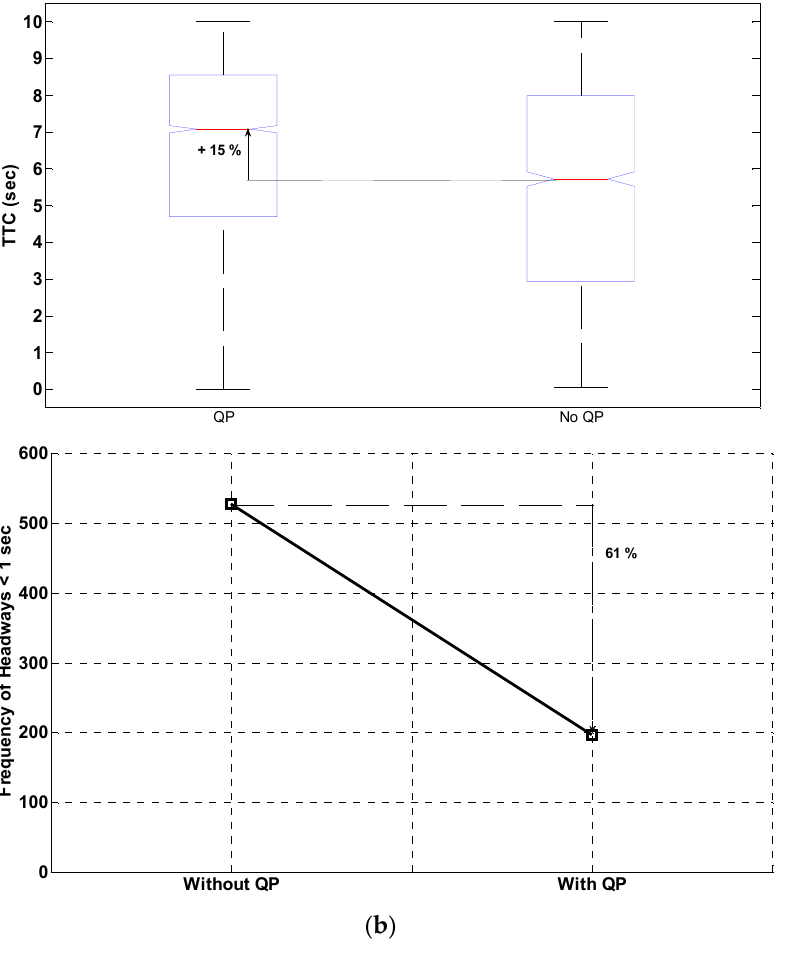
Figure 11. ( a ) The effect of VSL in a crash scenario on mean TTC and short headway frequency obtained from a simulation using the Gipps. ( b ) The effect of VSL in a crash scenario on mean TTC and short headway frequency obtained from a simulation using the SBM.